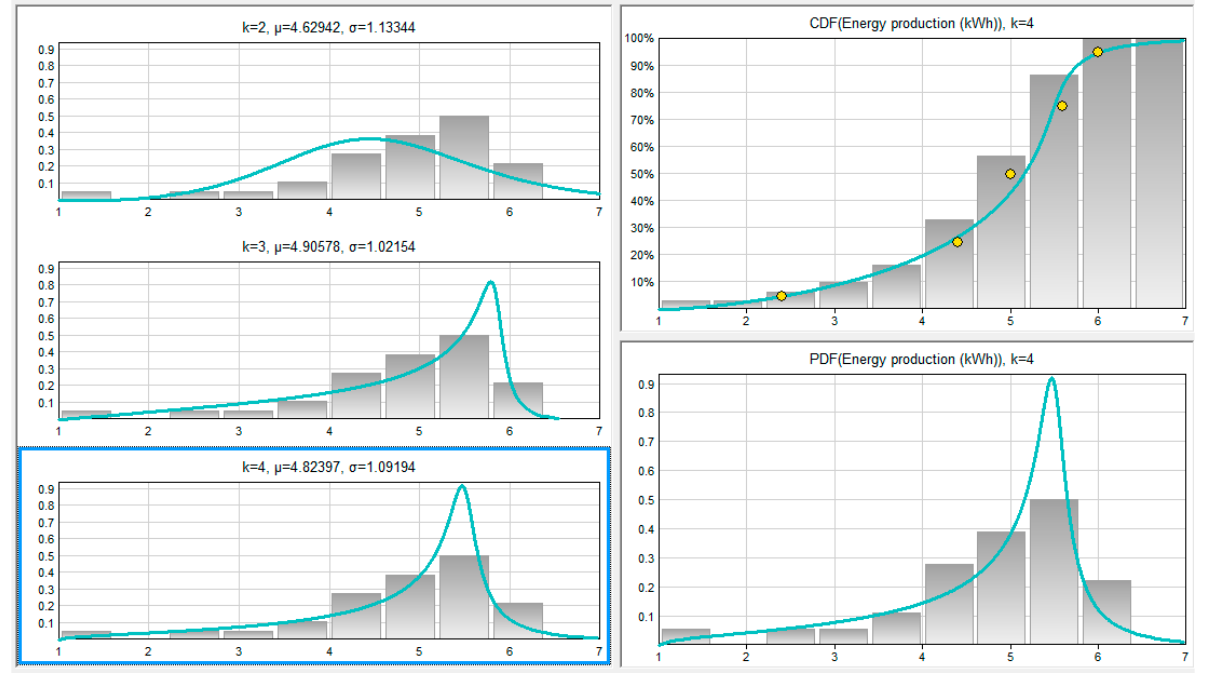
Figure 8. Empirical Distribution Function (sea color line) along with quantile parameters (yellow symbols) and Probability Density Function (sea color line) for the daily energy produced by the WSEI carport in the month of June 2022 for various k coe ffi cients.